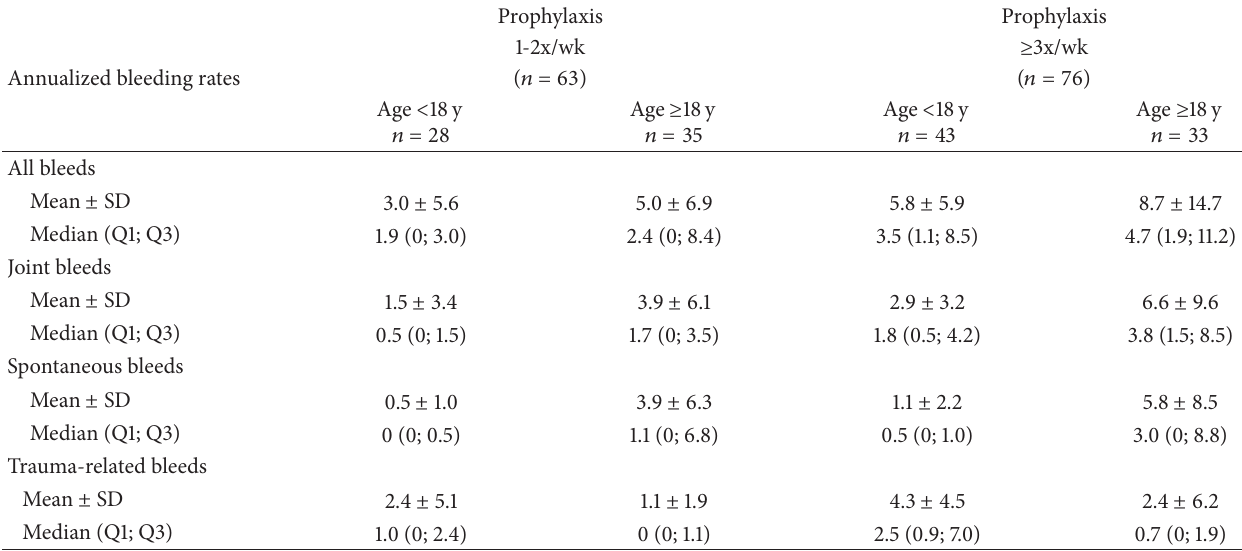
Table 3: Annualized bleeding rates by dosing and age subgroups.